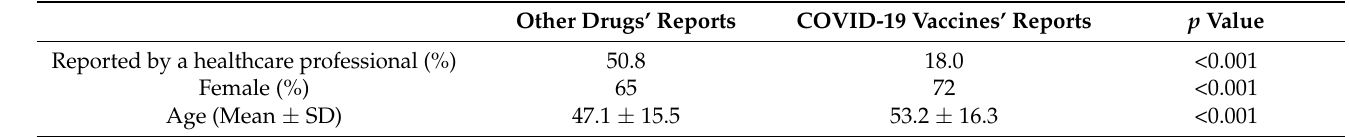
Table 2. Characteristics of the reports of patients with parosmia (COVID-19 vaccines vs. other